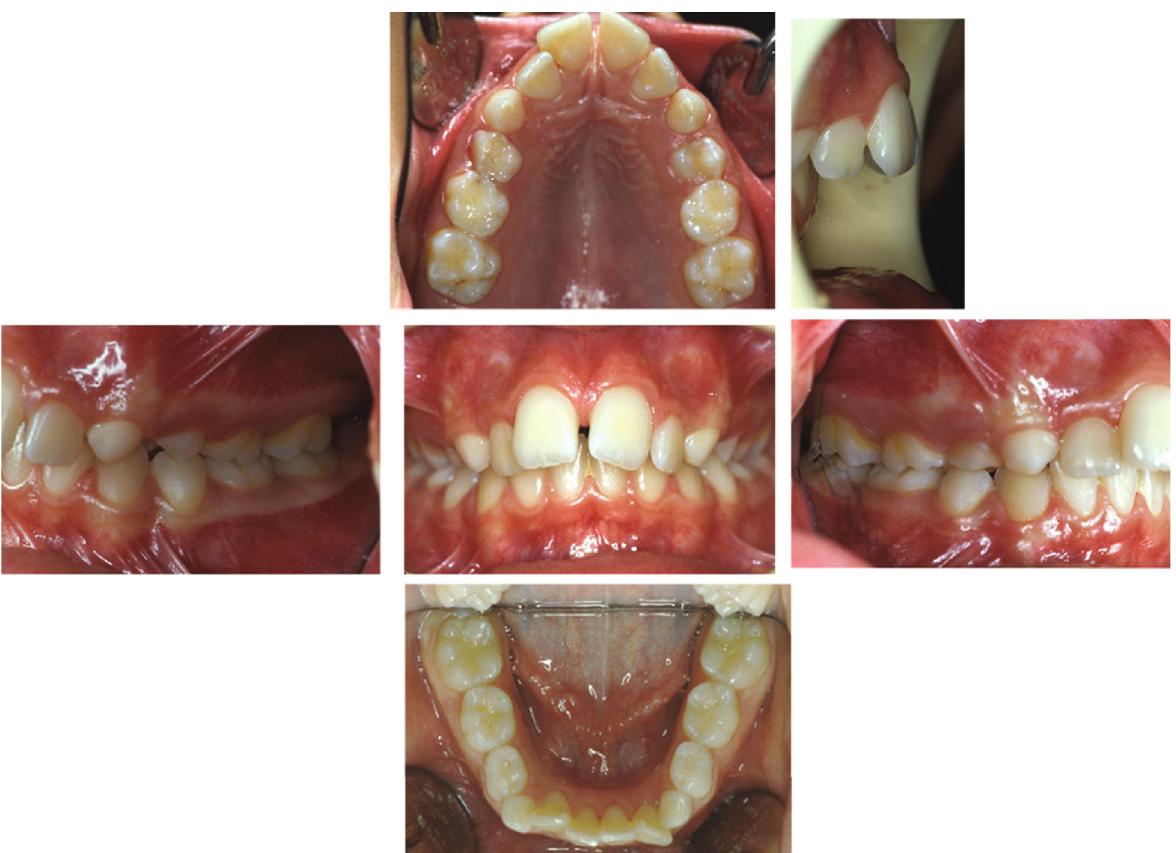
Figure 2: Initial intraoral